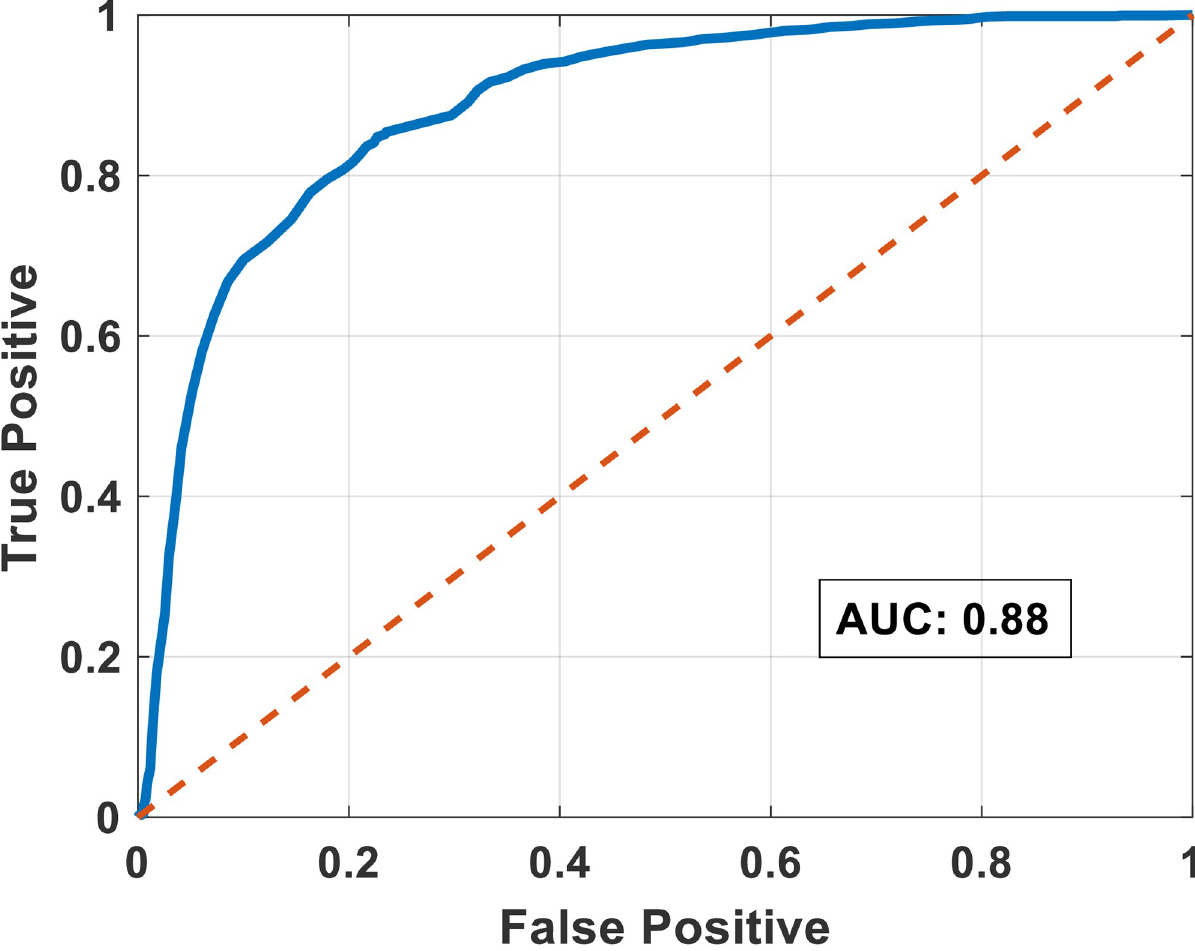
Fig 3. Receiver operating characteristics curve for communication detection; area under curve (AUC) = 0.88.